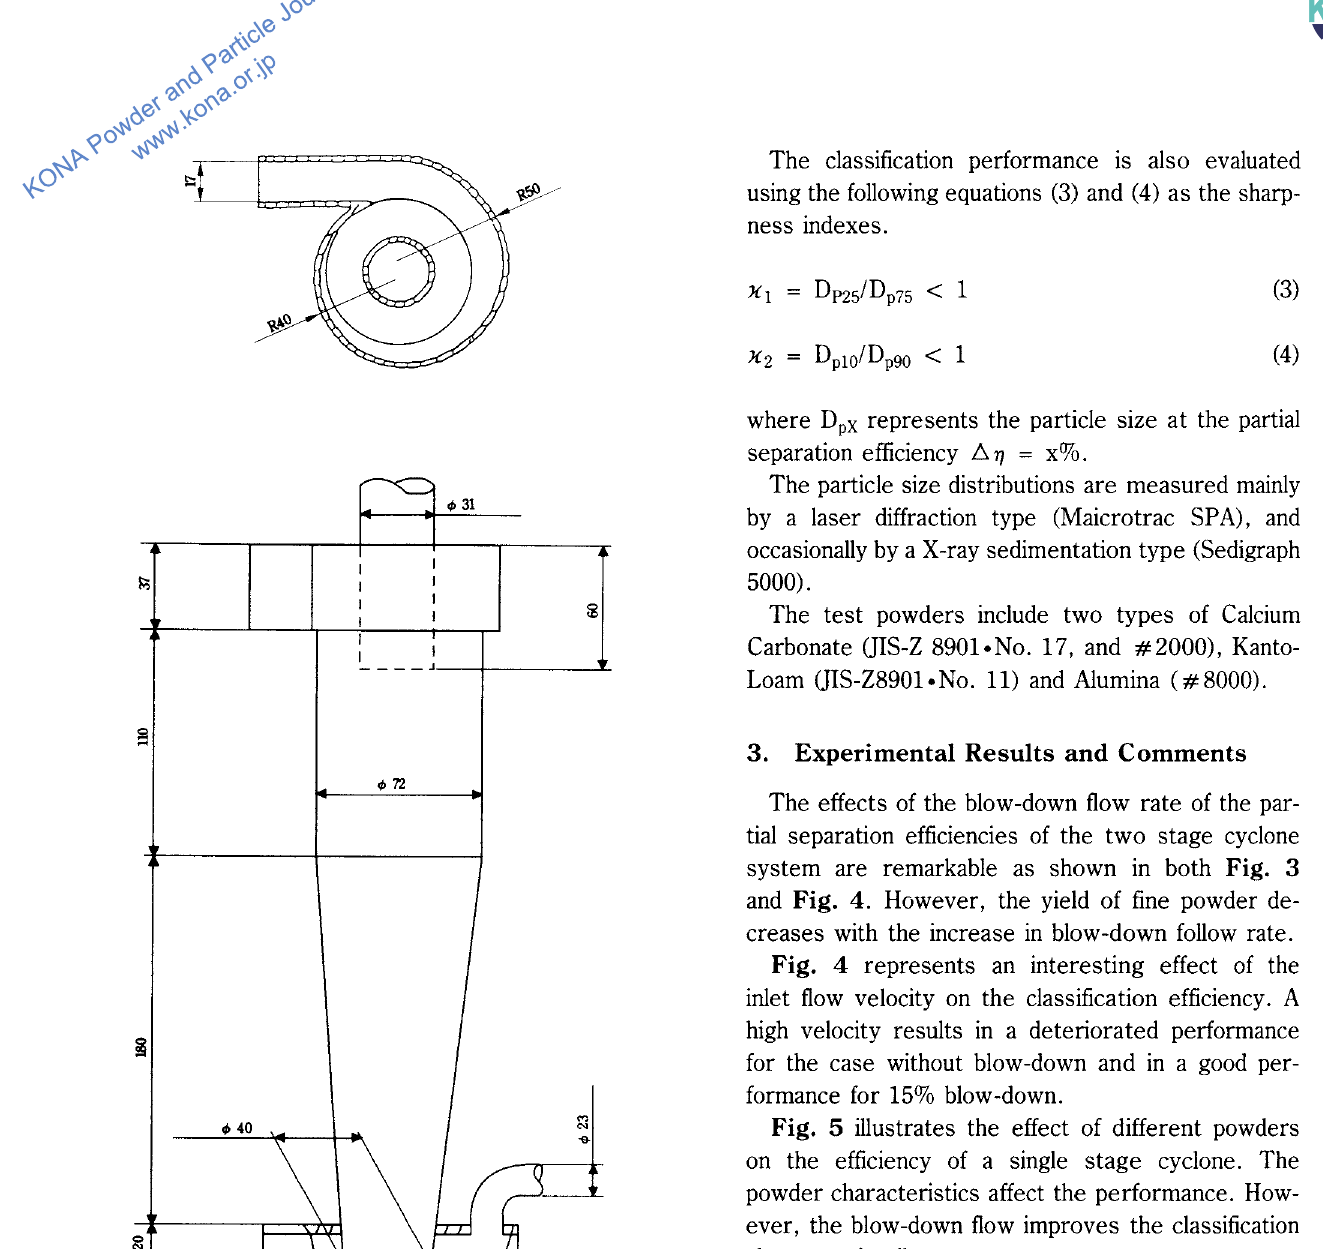
Fig. 1 </>70 mm Cyclone with bottom cone